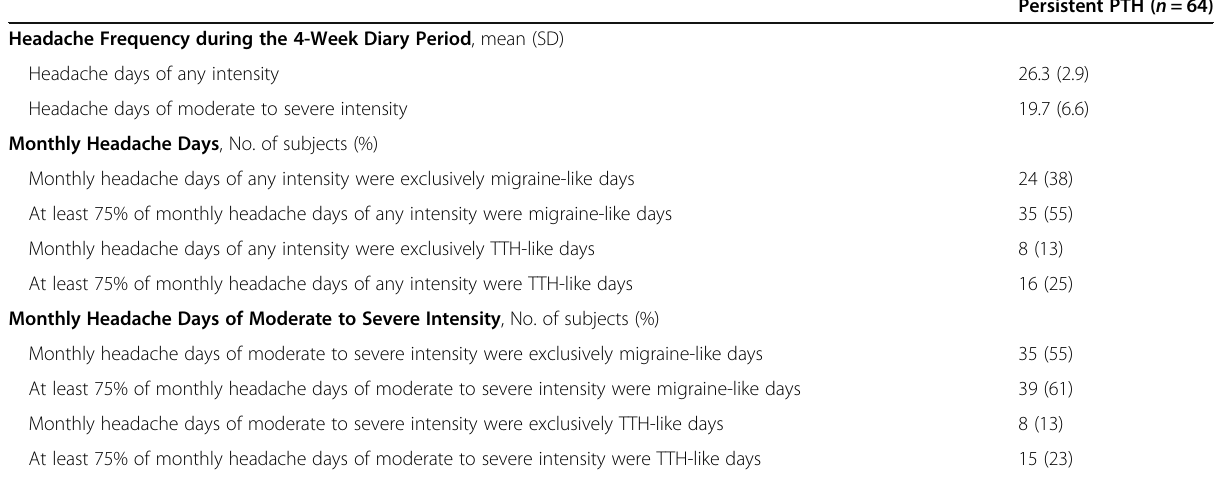
Persistent PTH ( n = 64)